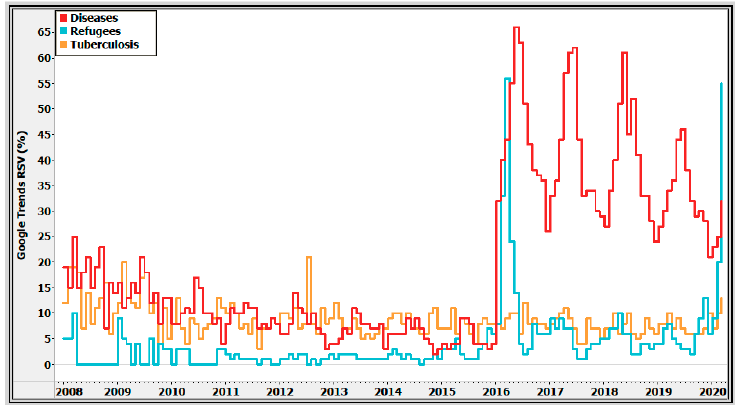
Figure 3. Google Search Trends for the search terms queries “refugees”, “diseases”, and